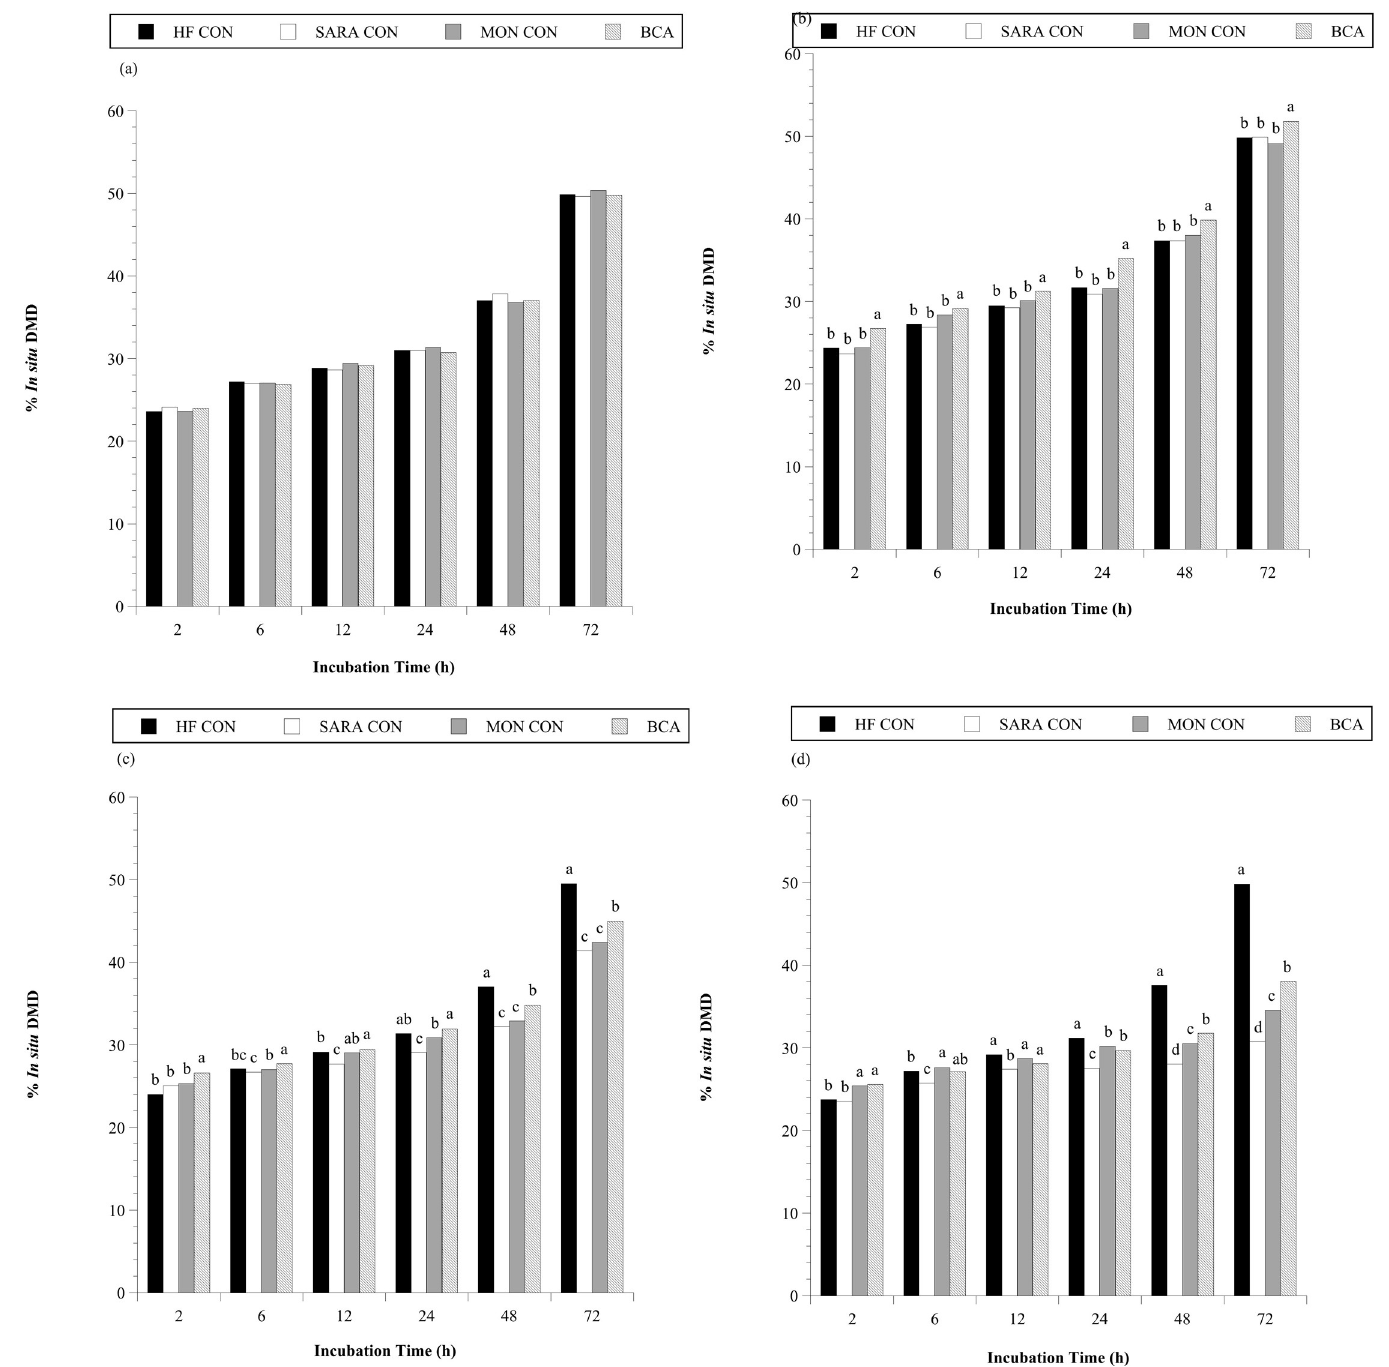
Fig 7. Effect of biochanin A addition on the in situ DM disappearance (% in situ DMD) of ground low quality grass hay in the steer rumen. Holstein steers (n = 12) were blocked by weight into 1 of 4 treatments: High fiber control (HF CON; basal diet control, corn silage + dried distillers’ grain, to meet protein requirements; n = 3), SARA control (SARA CON; n = 3), SARA + monensin treatment (MON CON; 200 mg d -1 monensin; n = 3), or SARA + biochanin A treatment (BCA; 6 g d -1 biochanin A; n = 3). In situ Dacron bags were added at 0, 24, 48, 60, 66, and 70 h of incubation into a weighted mesh bag in the rumen and removed together at 72 h on the last day of the (a) adaptation period (100% basal diet) (b) high fiber period (100% basal diet + treatments), (c) 60:40 SARA challenge period (60% basal diet + 40% cracked corn + treatments, as fed basis), and the (d) 30:70 SARA challenge period (30% basal diet + 70% cracked corn + treatments, as fed basis). Means lacking a common English letter are different within incubation time ( P < 0.05); Treatment: P < 0.0001; Pooled SEM: Treatment = 0.4265.